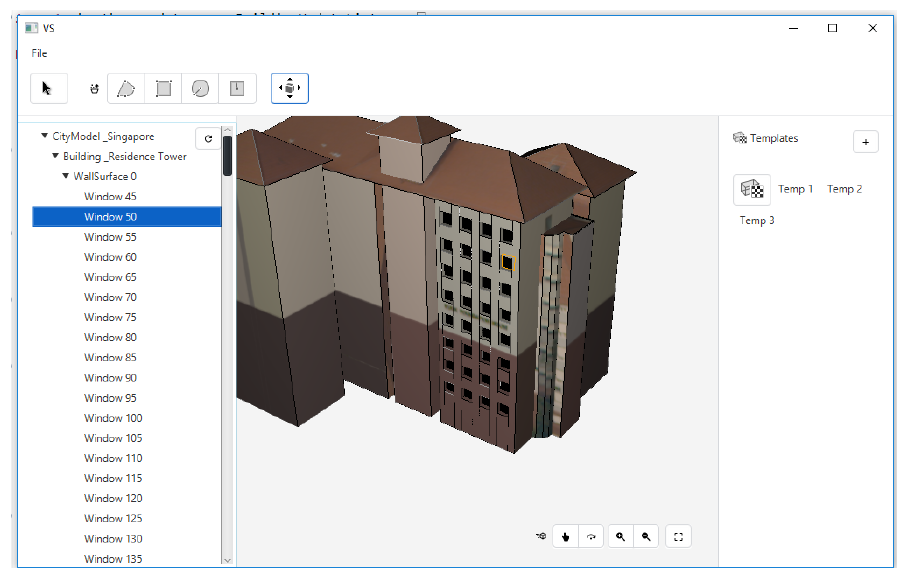
Figure 18. User interface of VSE.